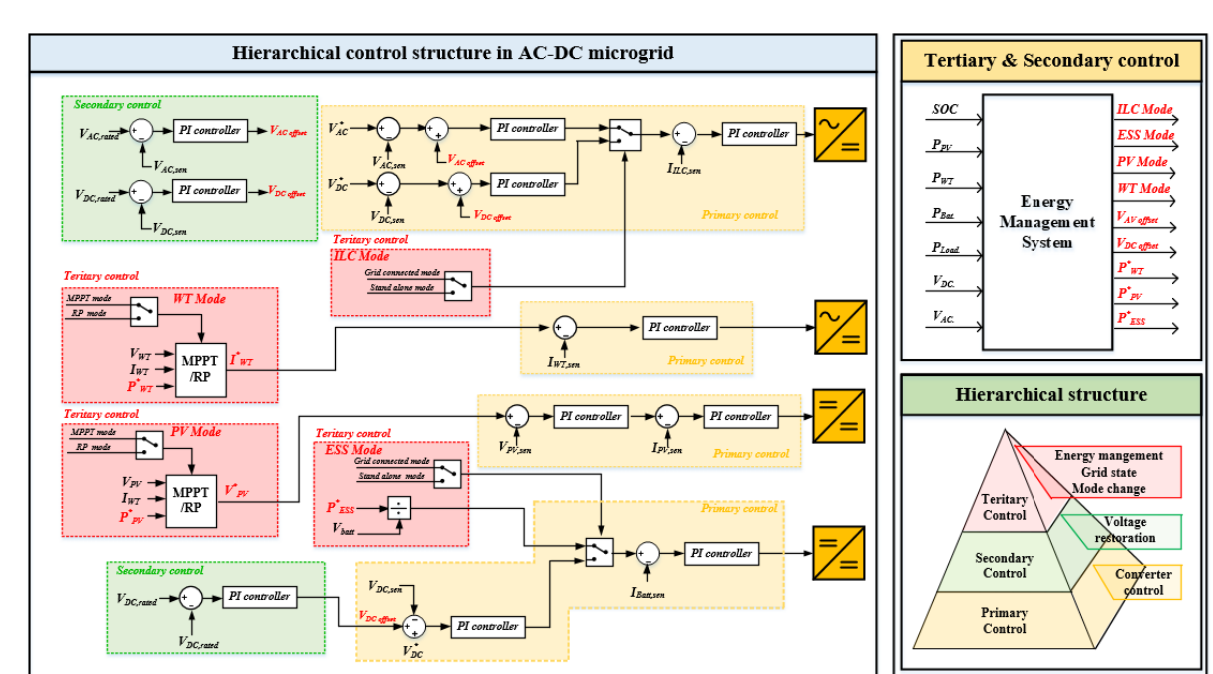
Figure 4. Hierarchical control structure of the proposed EMS and control block diagram of each power converter.